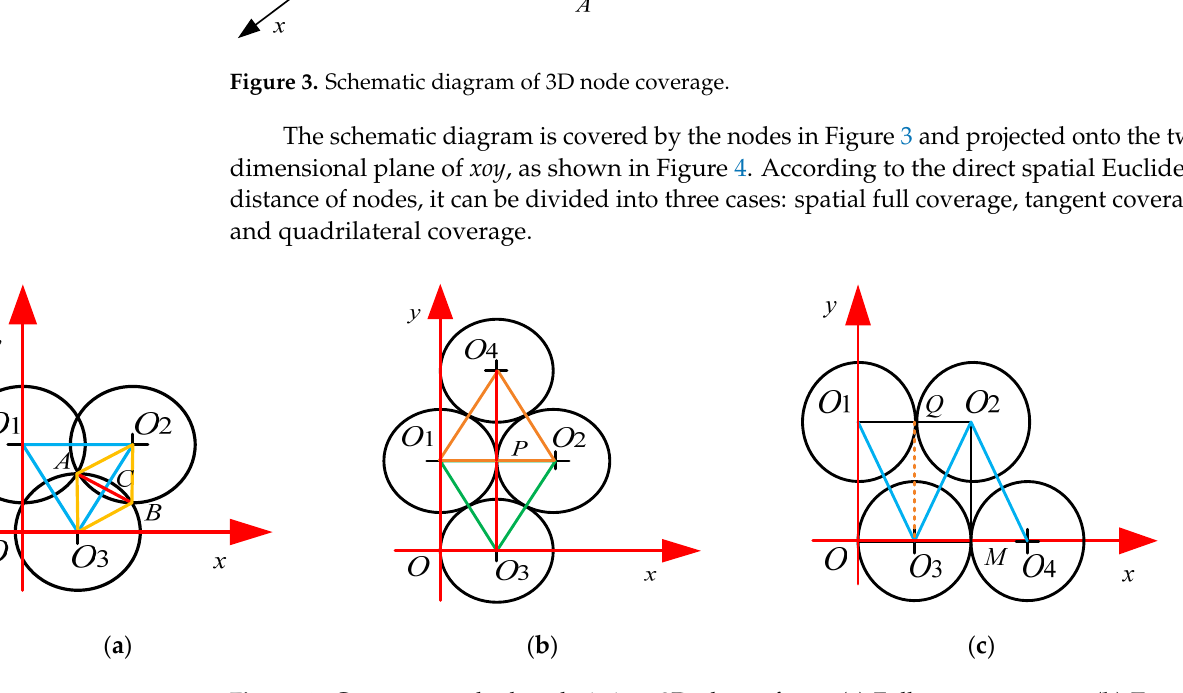
Figure 4. Coverage method analysis in a 2D plane of xoy. ( a ) Full space coverage. ( b ) Tangent coverage. ( c ) Quadrilateral coverage.